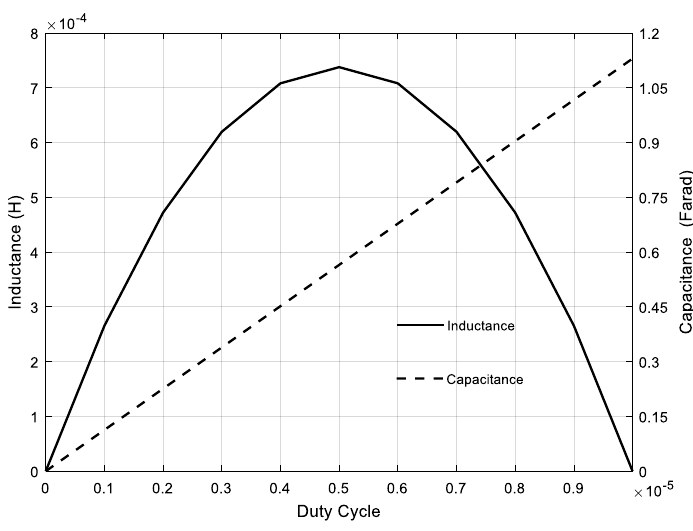
Figure 5. Boost converter inductance and capacitance variation with the duty cycle.